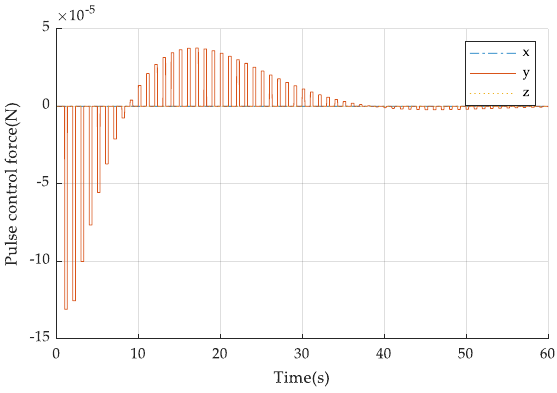
Figure 13. Pulse control curve.